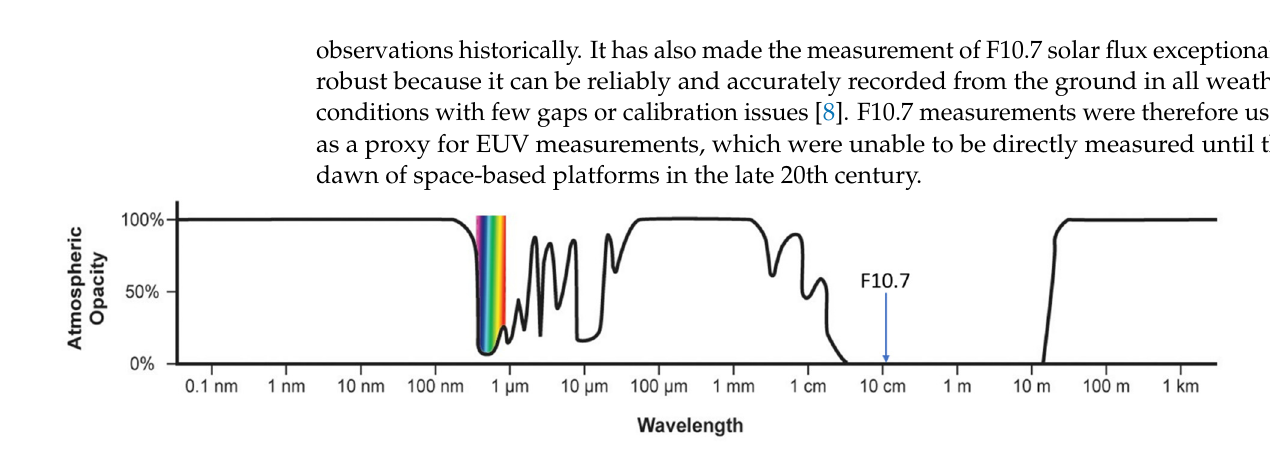
Figure 1. Absorption windows for wavelengths within the Earth’s atmosphere. While the 10.7 cm radiation falls within a window of atmospheric transparency for transmission, the atmosphere is opaque to EUV wavelengths (10 to 120 nm) due to neutral particle absorption. The transmission of wavelengths more than 10 m is increasingly affected by charged particles in the ionosphere, with the minimum frequency of penetration governed by the local total electron content (TEC). Adapted from [9].